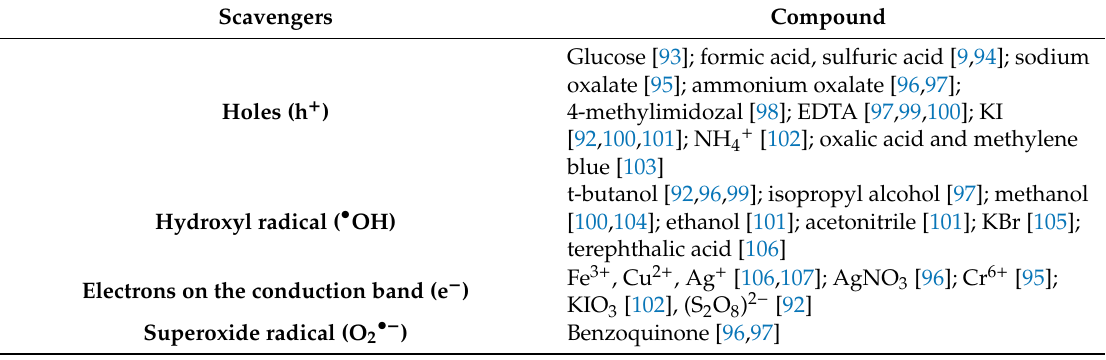
Table 4. Several radical scavenger agents used in a typical photocatalytic